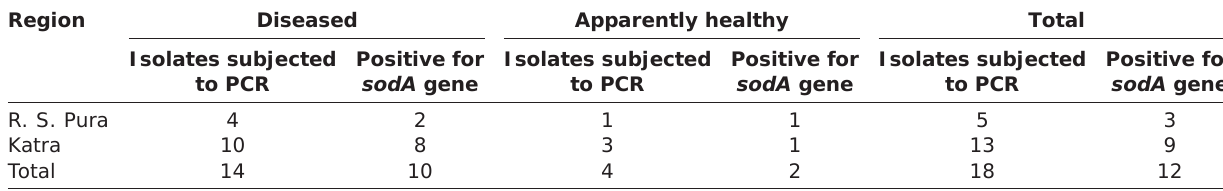
Table-4: PCR-based distribution of sodA gene from apparently healthy and diseased equines. Region